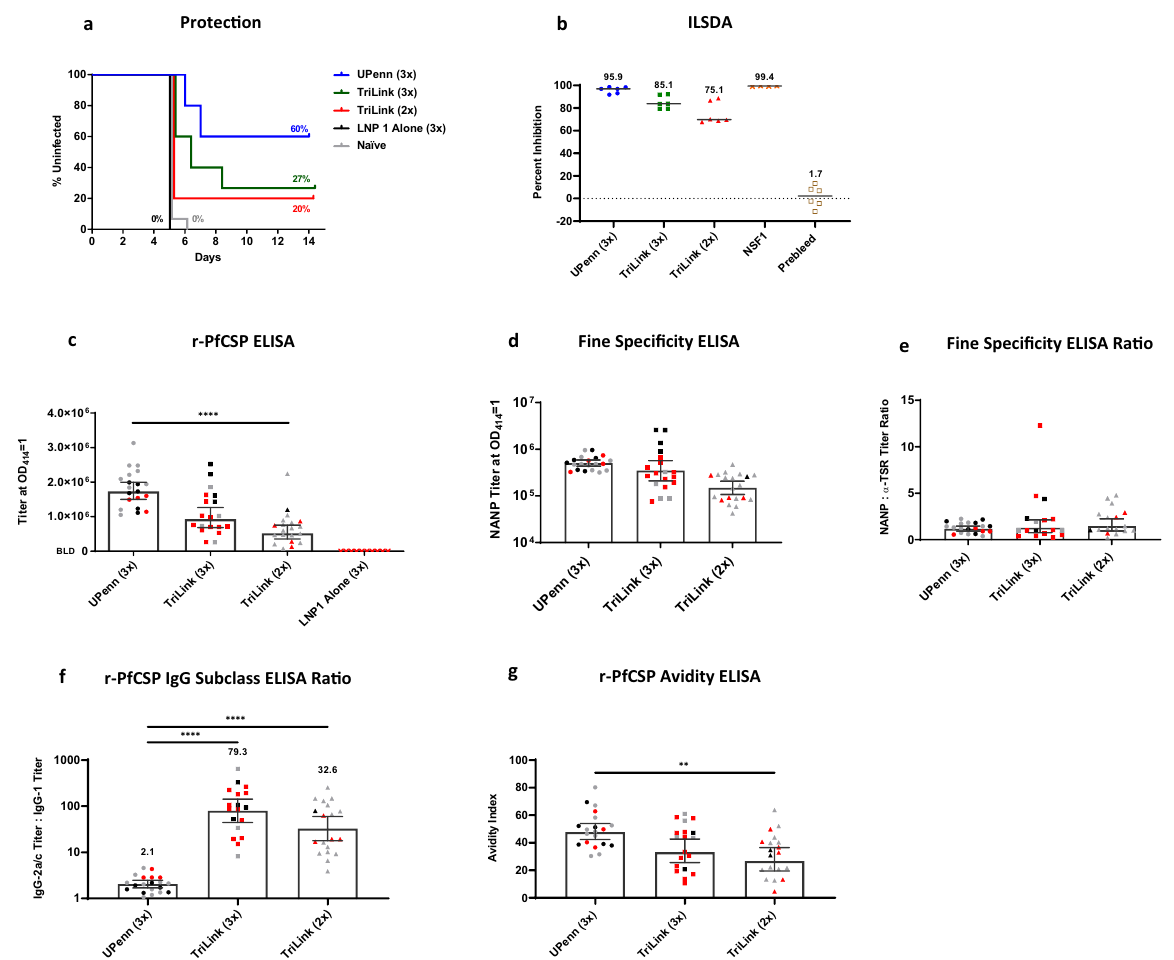
Fig. 4 PfCSP mRNA-LNP1 induced responses in C57BL6. A 10 μ g dose of PfCSP mRNA-LNP1, TriLink, and UPenn, prime:boost (2x) or prime: boost:boost (3x) regimen on a 3-week interval was tested against Pb(ANKA)-PfCSP (Wellcome) transgenic parasites ( N = 15 per group for TriLink 3x and naïve controls) ( N = 10, UPenn 3x) ( N = 5 per group for TriLink 2x and LNP1 alone) with 1000 sporozoites injected intravenously, 2 weeks post fi nal immunization. a Kaplan – Meier curves report the percent survival of challenged mice. Ef fi cacy was calculated against the negative controls (LNP1 alone and naïve controls). Survival was de fi ned as mice without detectable parasitemia by thin blood smear by day 14. b Functional activity of the antibodies was quanti fi ed by the ILSDA using pooled mouse serum of each group. Inhibition was calculated relative to the mean of sporozoite invasion in the absence of mouse serum. Data are reported as the mean of assay replicates. c r-PfCSP ELISA ( N = 20 per group for UPenn 3x, TriLink 2x) ( N = 19, TriLink 3x) ( N = 10, LNP1 alone), d fi ne speci fi city ELISA against the (NANP) 6 repeat peptide ( N = 20 per group for UPenn 3x, TriLink 2x) ( N = 19, TriLink 3x), e fi ne speci fi city ELISA are reported as the ratio of the (NANP) 6 titer to the α -TSR titer ( N = 20, UPenn) ( N = 17 per group for TriLink 3x, TriLink 2x), f the ratio of r-PfCSP IgG subclass titers for IgG1 and IgG2a ( N = 20, UPenn 3x) ( N = 18, TriLink 3x) ( N = 19, TriLink 2x) and g r-PfCSP avidity ELISA ( N = 20, UPenn 3x) ( N = 19 per group for TriLink 3x, TriLink 2x). Uninfected, infected, and unchallenged mice are represented by black, red, and gray symbols, respectively. Data in the bar graph are reported as the GM with 95% CI. All statistical analyses were performed using one-way ANOVA on ranks, Kruskal – Wallis post hoc Dunn ’ s multiple comparison test (** p < 0.01; **** p <